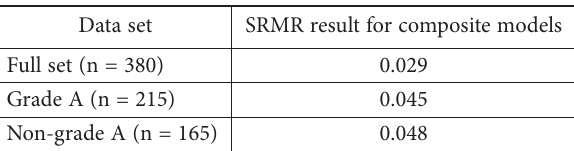
Table 5. SRMR model fit